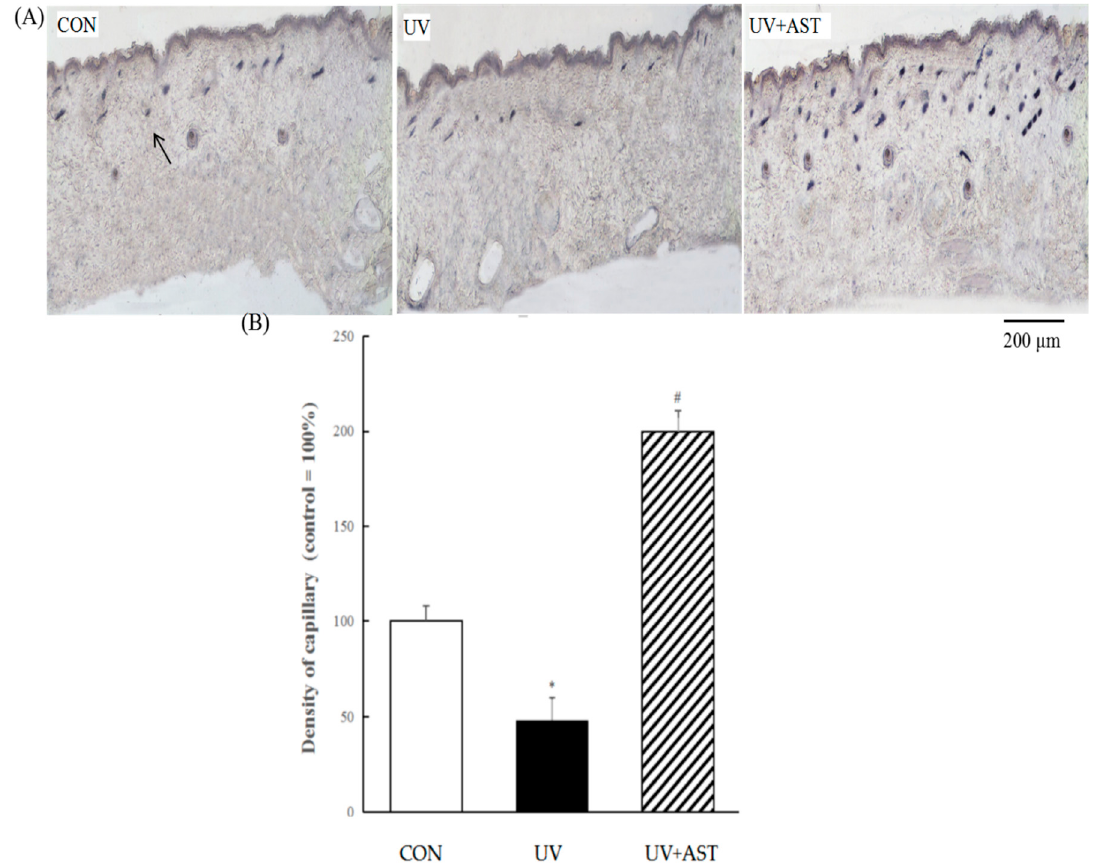
Figure 4. The effect of AST on changes in the density of capillary vessels in the dorsal skin of ultraviolet (UV)-induced mice. ( A ) AP staining. Arrow indicates the cross-section of a capillary. Scale bar = 200 μ m. ( B ) Treatment with AST significantly suppressed the UV irradiation-induced regression in capillary vessels. * p < 0.01 vs. control mice; # p < 0.1 vs. UV-induced mice.